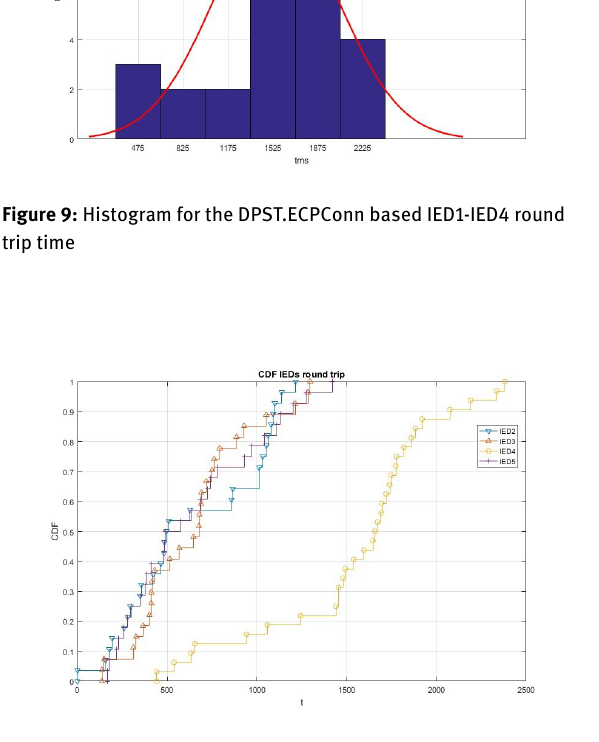
Figure 10: Histogram for the DPST.ECPConn based IED1-IED5 round trip